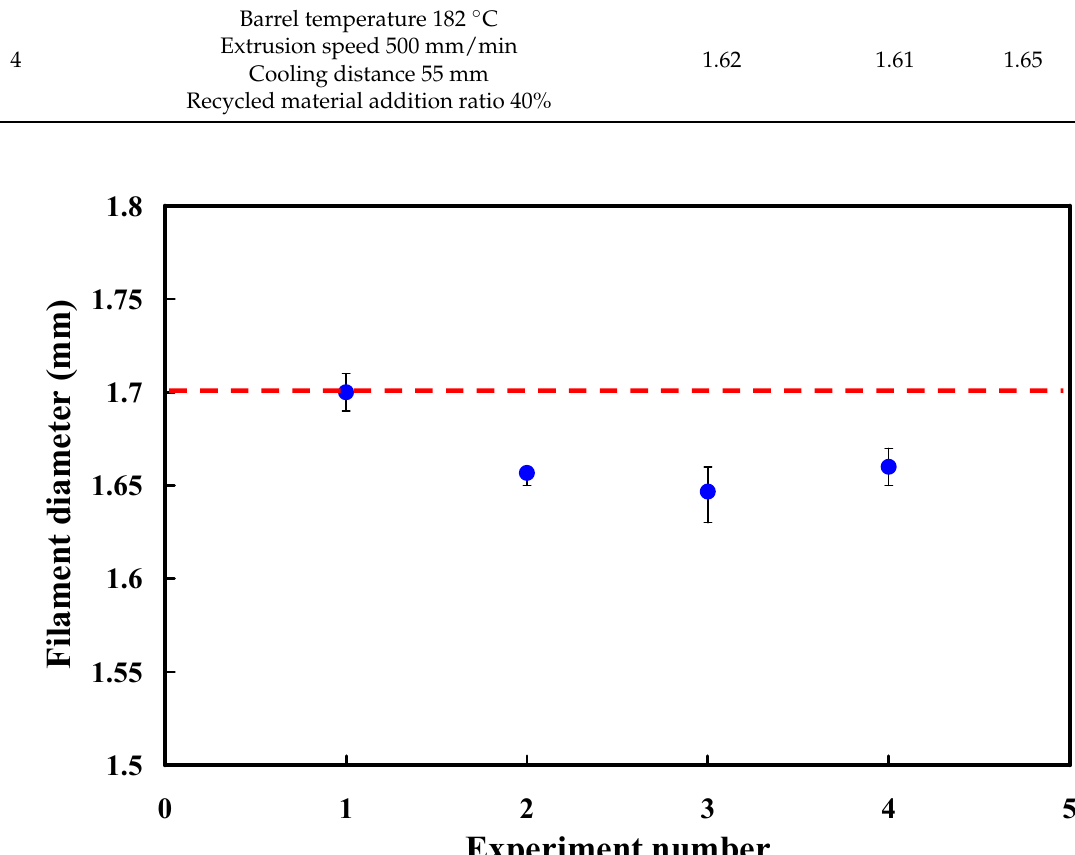
Figure 11. Results of the verification experiments.